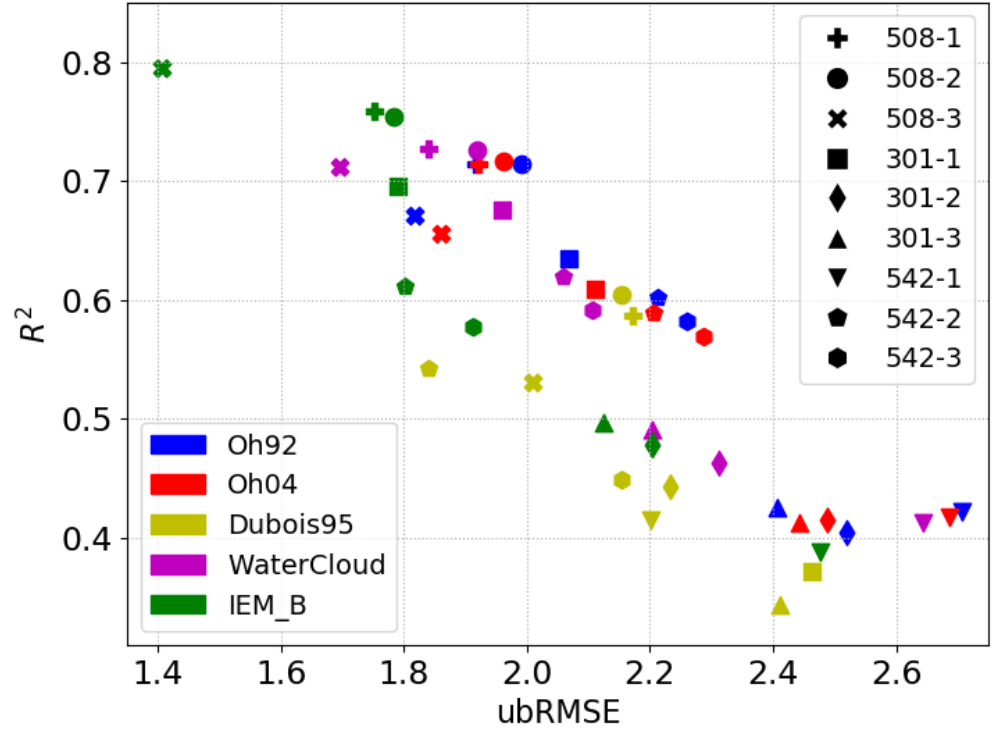
Figure 11. Scatter plot showing statistical validation results (correlation coefficient R 2 and ubRMSE) for canopy model WCM separated by different surface models (colors) and different field points